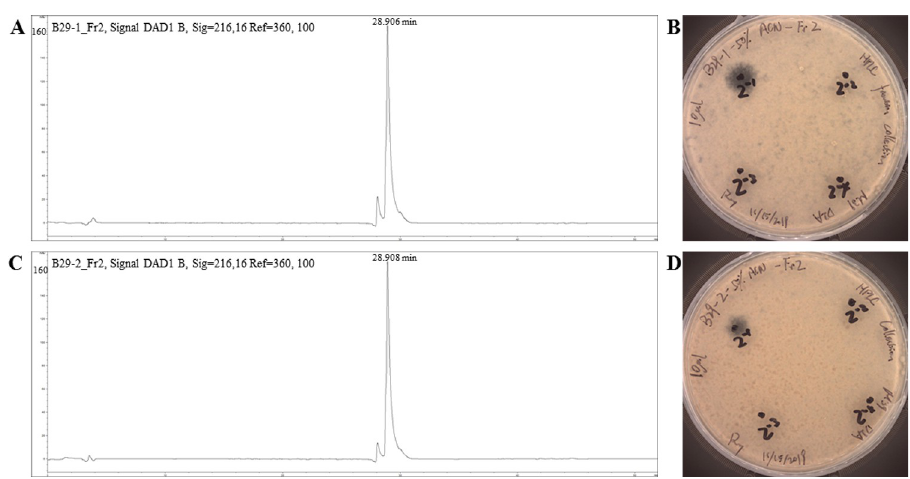
Fig 2. Reversed-phase HPLC of purified products of Bacillus velezensis WRB-ZX-001 and WRB-ZX-002. Purification process included ammonium sulfate precipitation, solid phase extraction, and HPLC fraction collection. Single peaks shown in A and C were from isolate WRB-ZX-001 and WRB-ZX-002, respectively, and both have shown inhibition against fungal indicator strain Aspergillus fumigatus as shown in B and D.